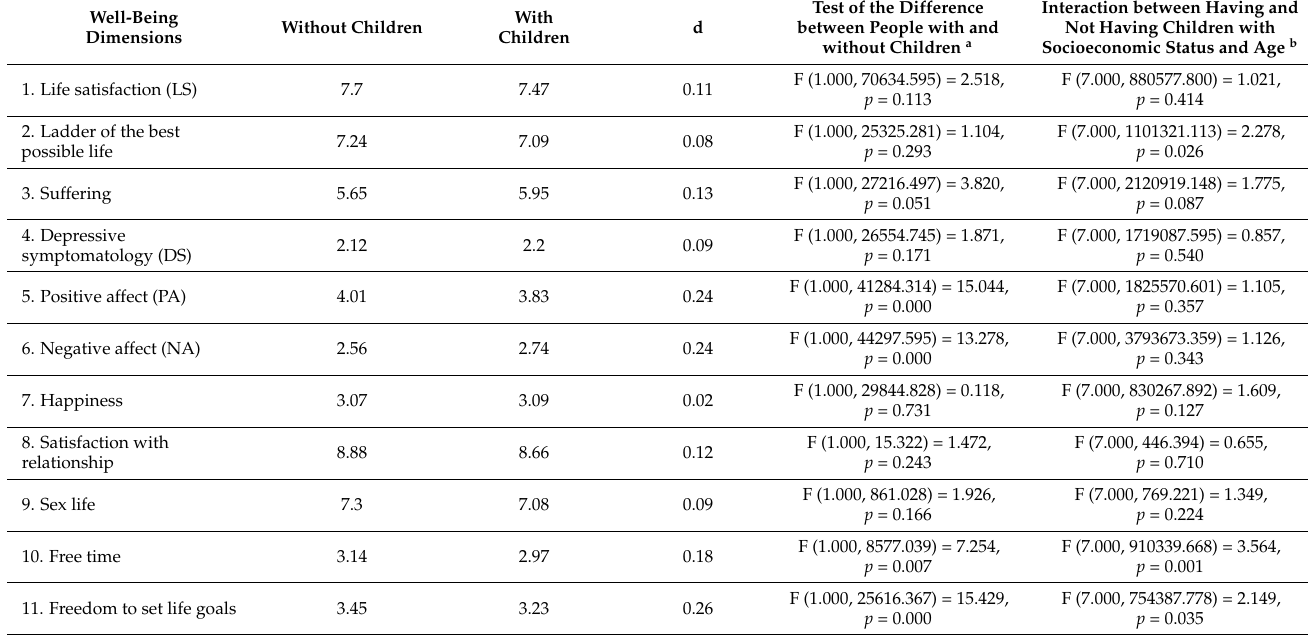
Table 3. Comparison between participants with and without children in different dimensions of well-being. Well-Being Dimensions Without Children